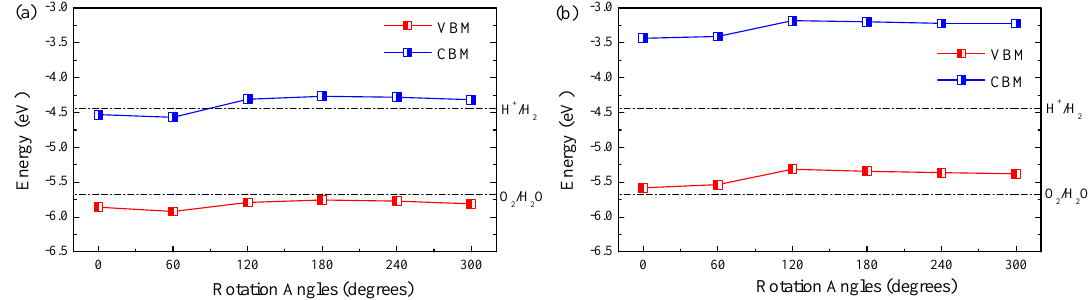
Figure 3. Band alignment of ( a ) ZnO/WS 2 and ( b ) ZnO/WSe 2 of different rotation angles with respect to the water redox